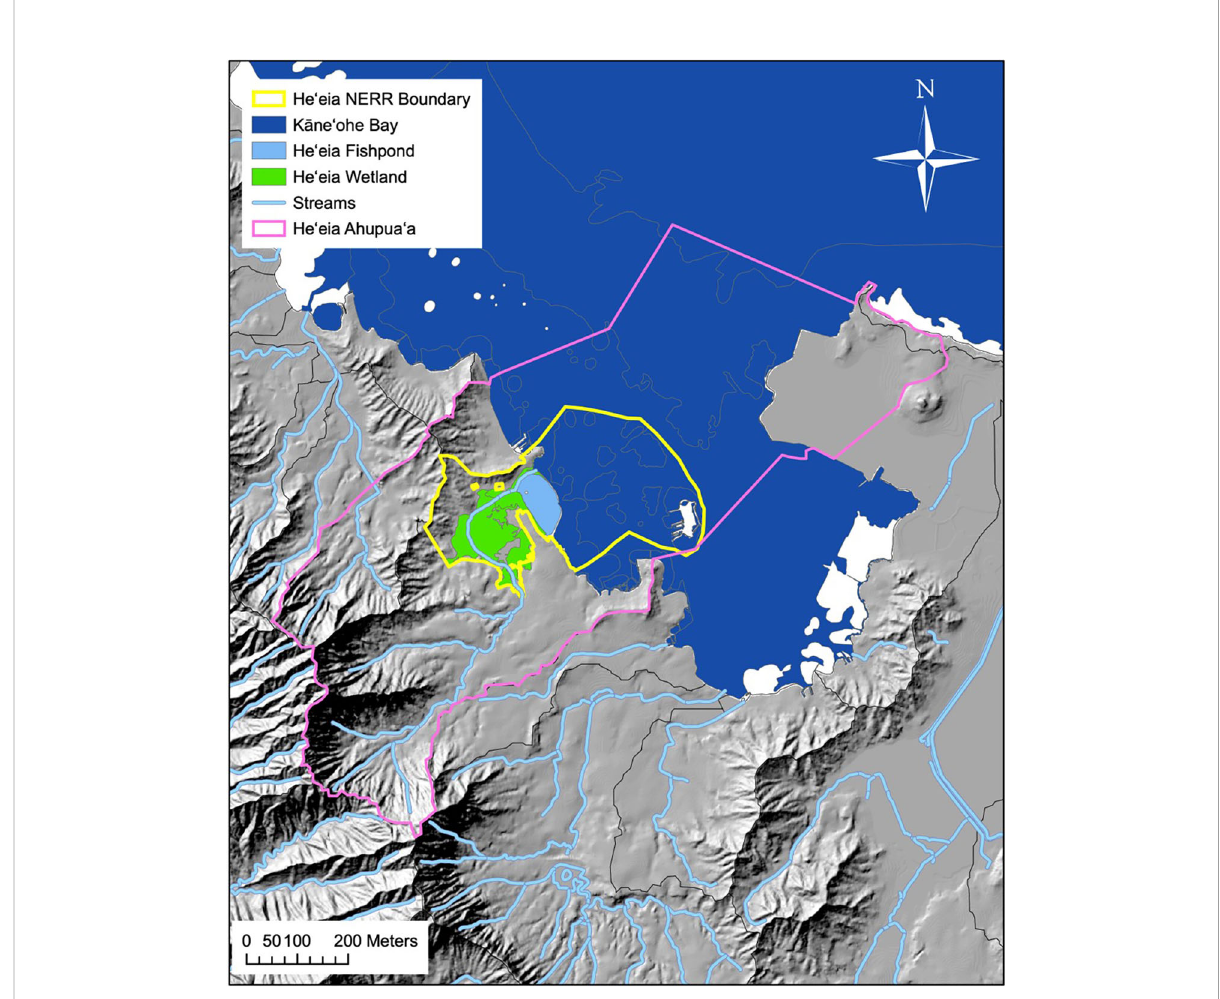
FIGURE 1 He ‘ eia ahupua ‘ a, Ko ‘ olaupoko, O ‘ ahu. Solid orange line represents ahupua ‘ a boundaries in the Hawai ‘ i Statewide GIS Program, with lines extended to include the approximately represented historical He ‘ eia fi shery following the ahupua ‘ a of He ‘ eia land commission award (L.C.Aw.10613, Ap.1 to A. Paki. From Public archives of Hawai ‘ i, Letter Folder 244-B, H.A. & R.L. 3/3/47). Map credit: He ‘ eia